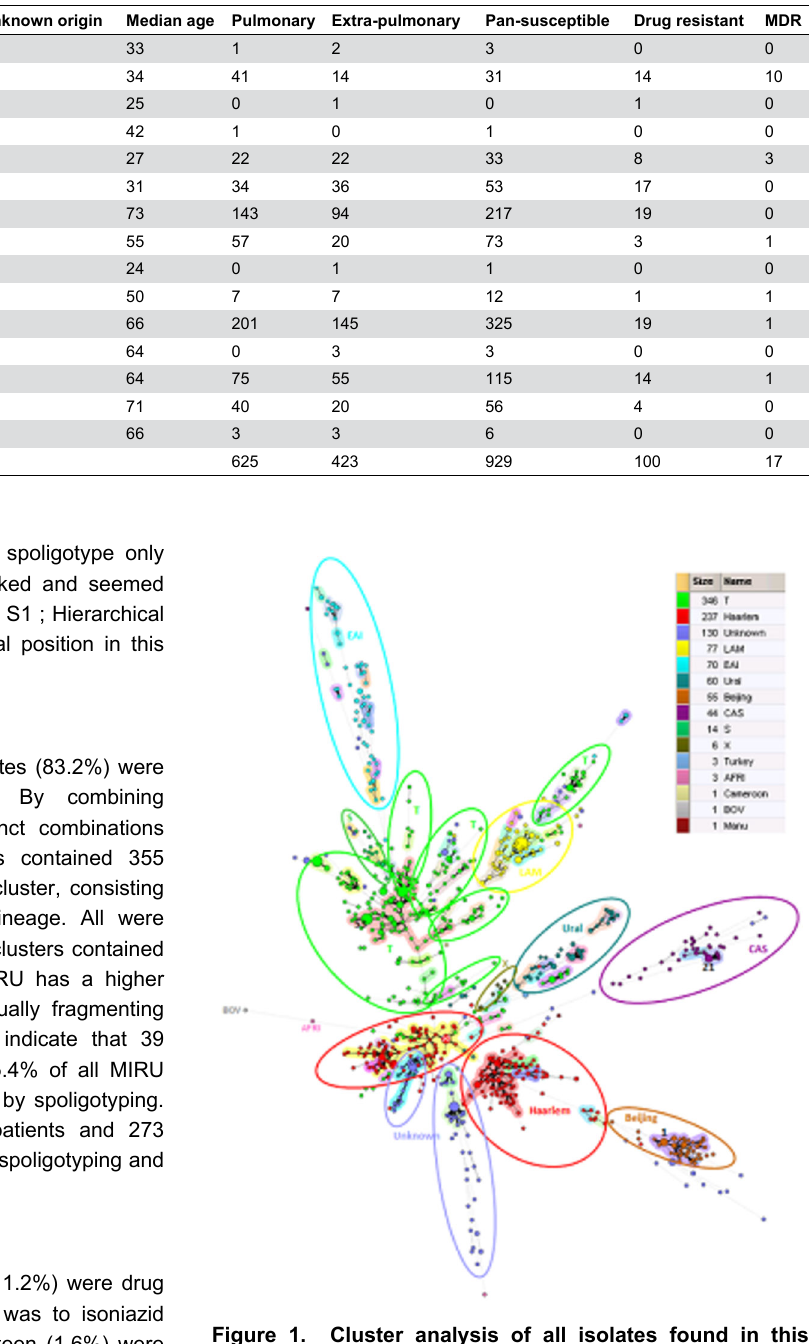
Figure 1. Cluster analysis of all isolates found in this study. Colors of nodes depict the lineage of the strain.